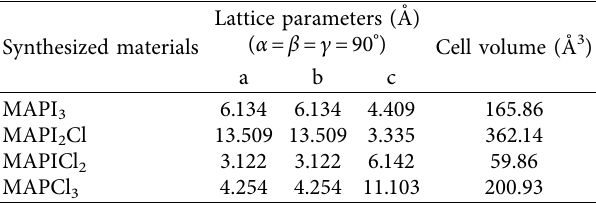
Table 1: Lattice parameters and volume for synthesized materials. Synthesized materials